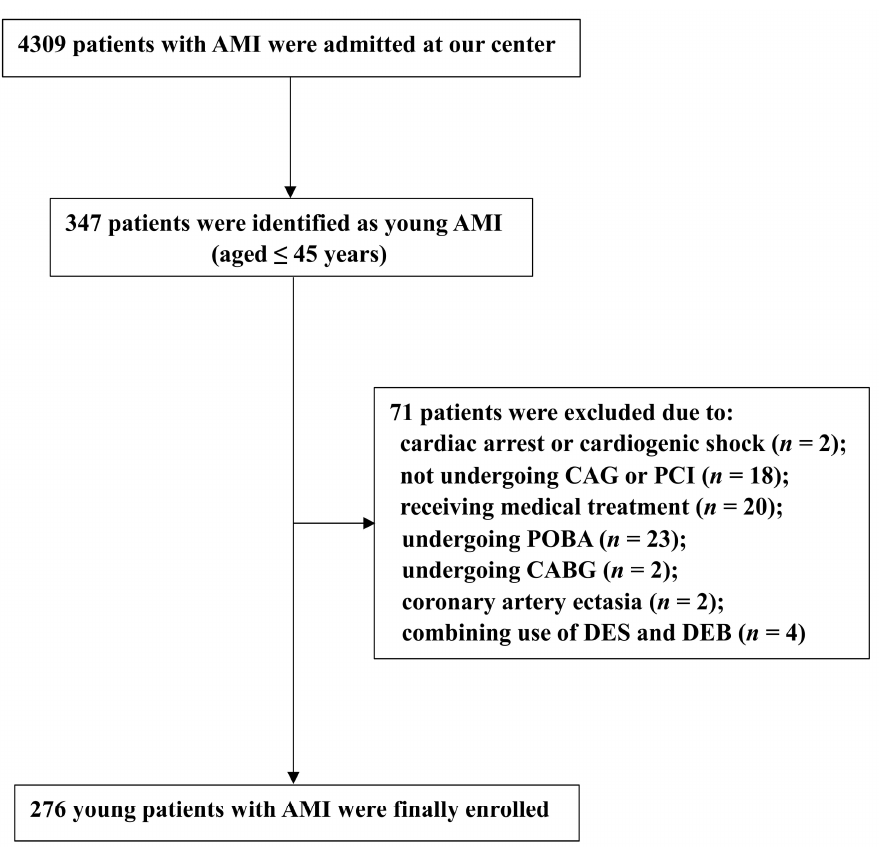
Figure 1. Patient Flow Chart. AMI: acute myocardial infarction; CAG: coronary angiography; PCI: percutaneous coronary intervention; POBA: plain old balloon angioplasty; CABG: coronary bypass surgery; DEB: drug-eluting balloon; DES: drug-eluting stent.